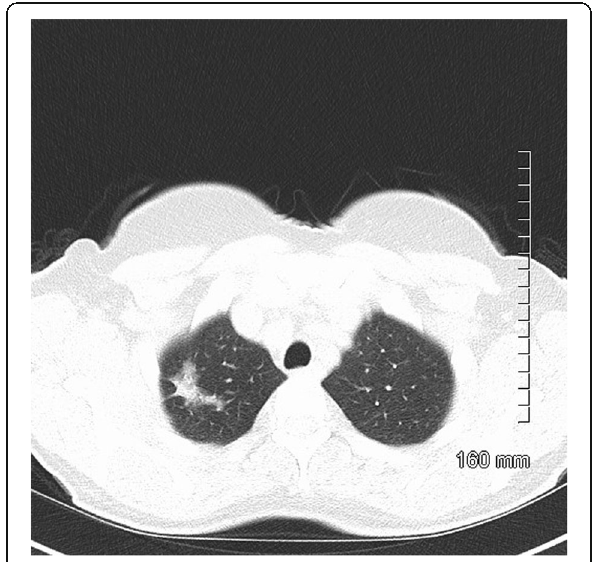
Fig. 16 Unfavourable prognostic indicators: large size (> 2 cm). The part-solid mass at the right apex measures 3.5 cm. MIA